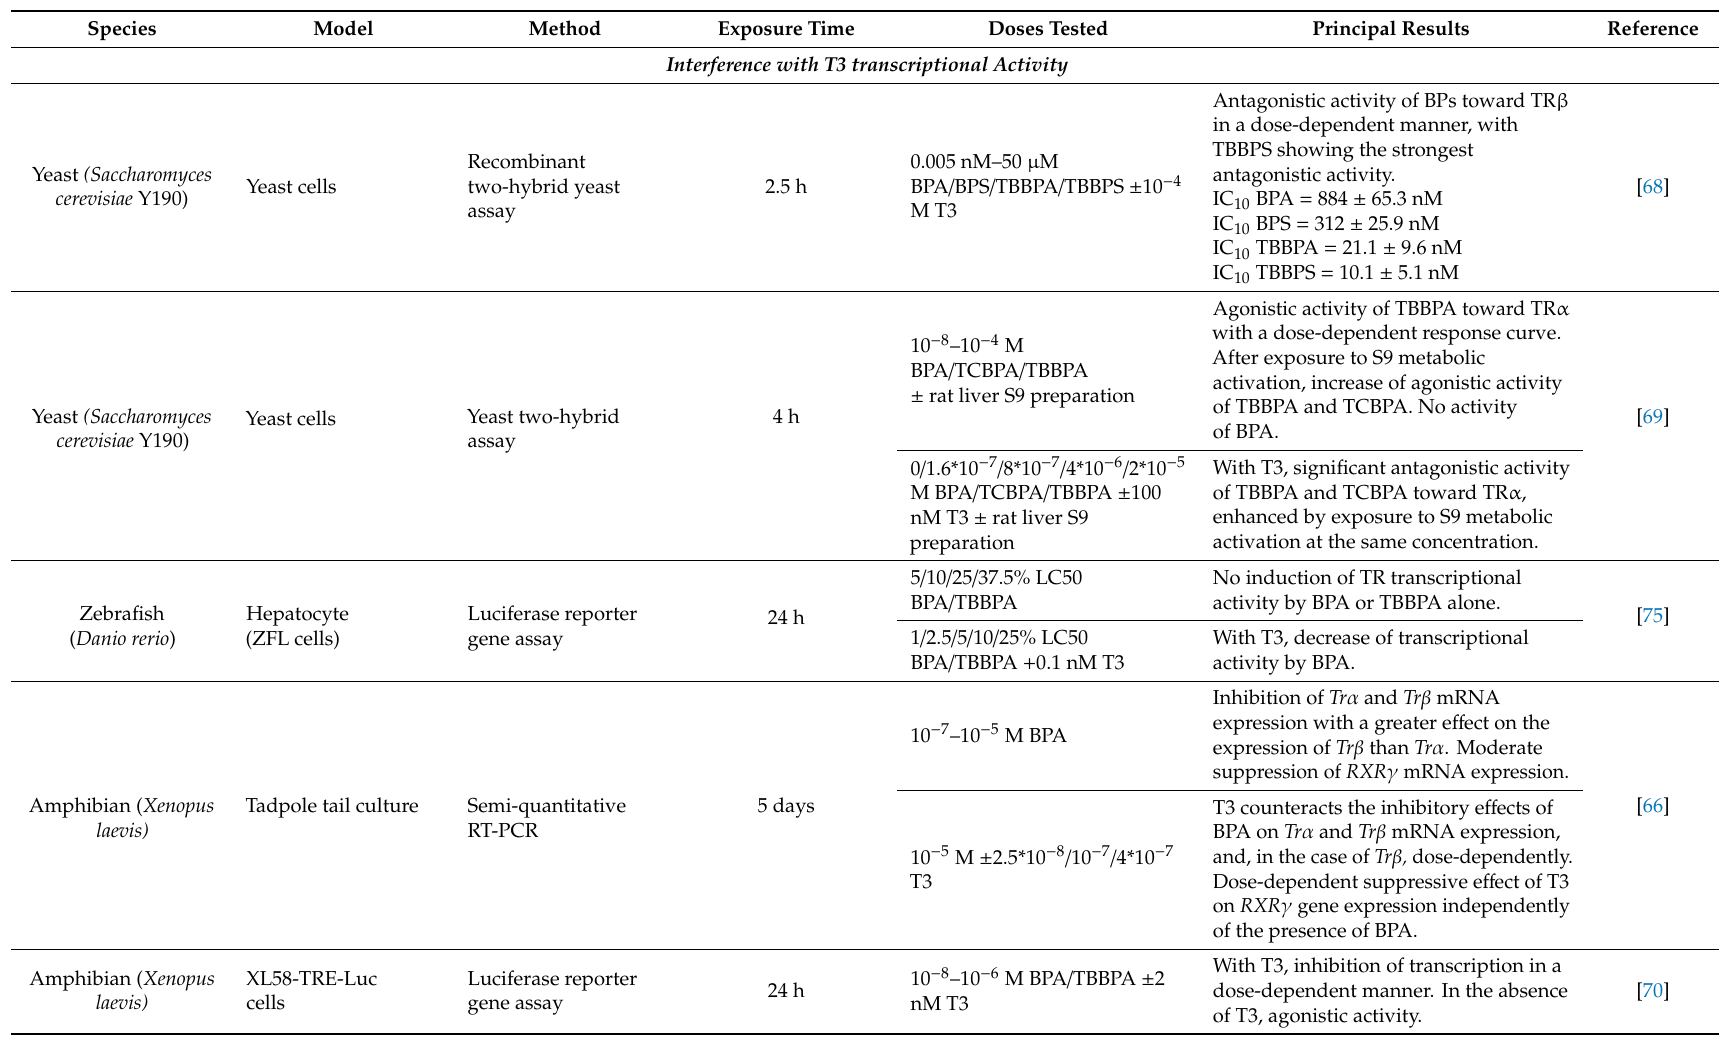
Table 2. Summary of in vitro studies analyzing e ff ects of bisphenols on thyroid hormoneresponsive cell